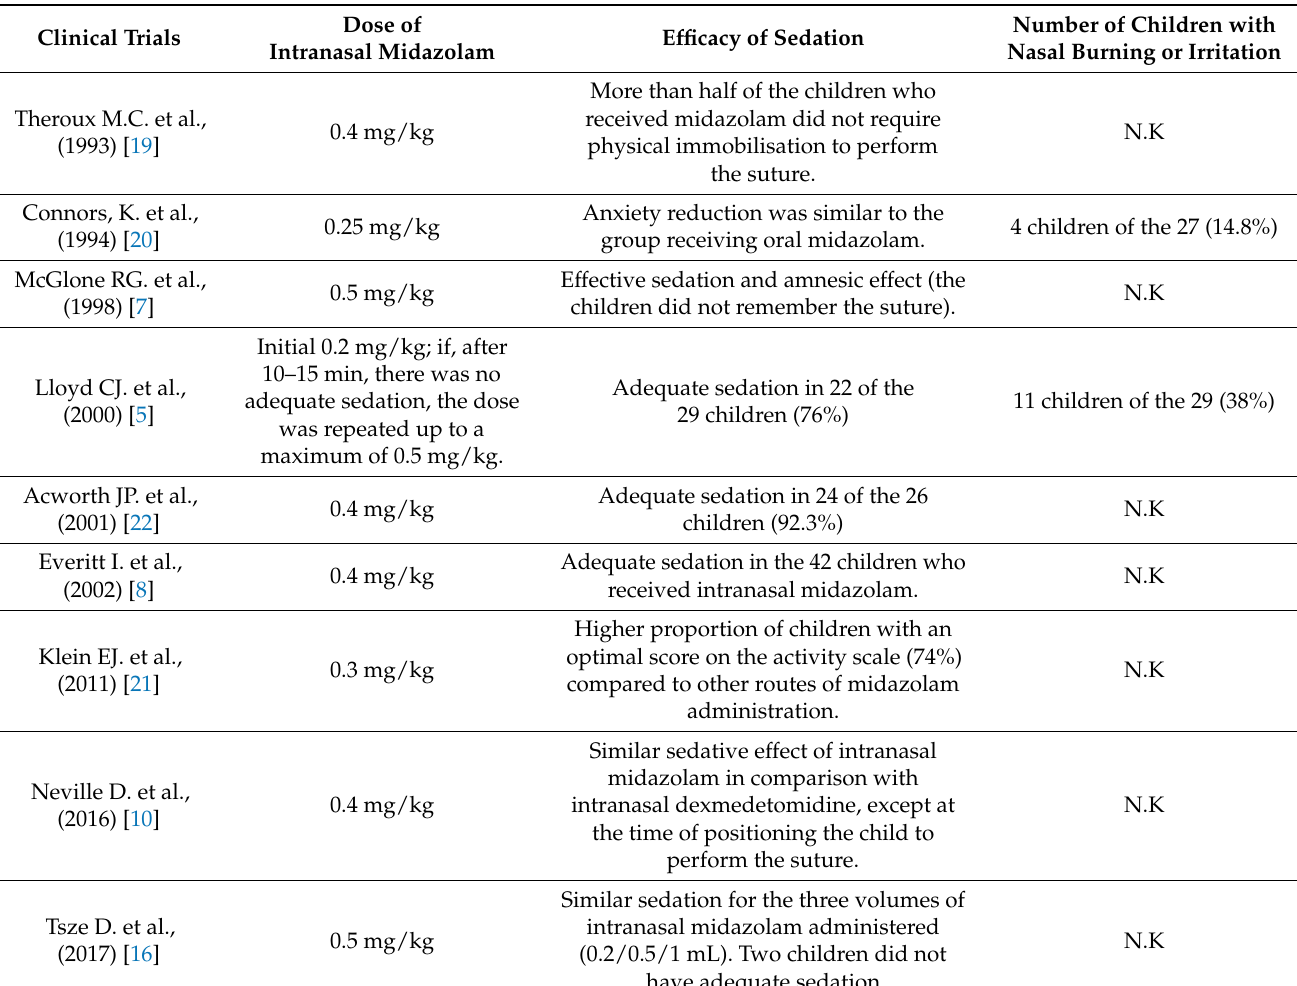
Table 7. Dose of intranasal midazolam, efficacy of sedation and adverse reaction (nasal